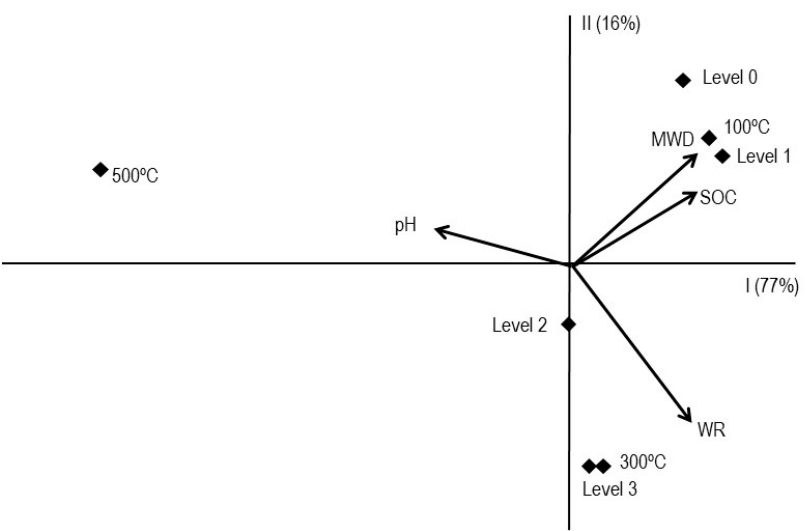
Figure 5. Samples and variables in the plane defined by the first two axes of the PCA (Level 0: Unburned; Level 1: Low severity; Level 2: Medium severity; Level 3: High severity).